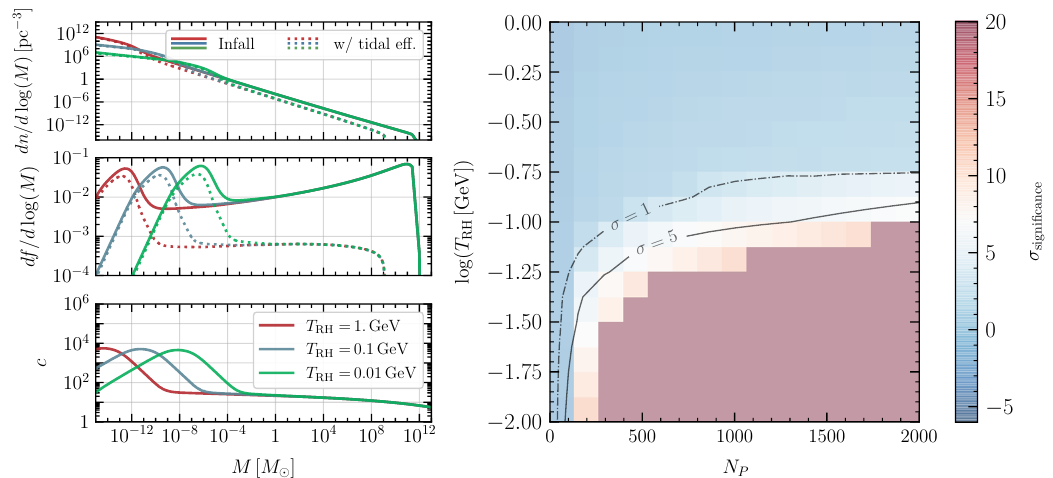
Figure 8 . Left : sHMF (top panel), and mass fraction per logarithmic mass interval (center panel) before (solid) and after (dashed) the inclusion of tidal effects. The lower panel shows the typical subhalo concentration parameter as a function of subhalo mass. All curves are shown for three values of the reheating temperature, T = 10 MeV , 100 MeV , 1 GeV . Right : discovery significance RH for different values of the reheating temperature and number of pulsars in the PTA. The residual timing noise, observation cadence, and observation time are 10 ns , 1 week , and 30 yr , respectively. The dashed (solid) line shows the 1 σ ( 5 σ ) significance